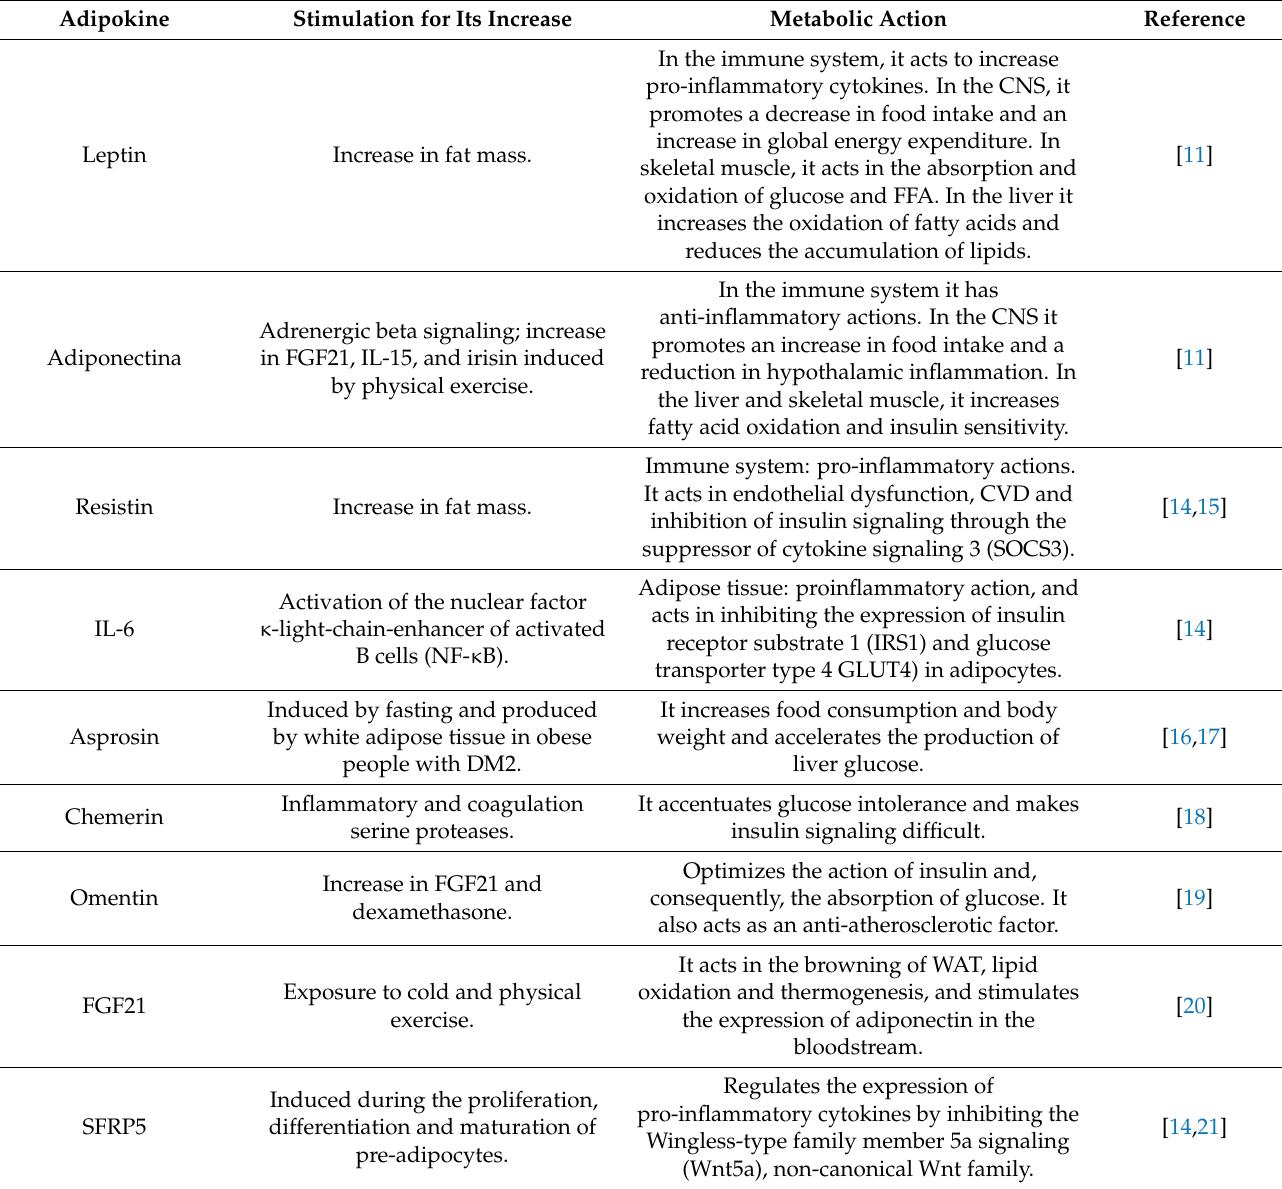
Table 1. Main characteristics of the